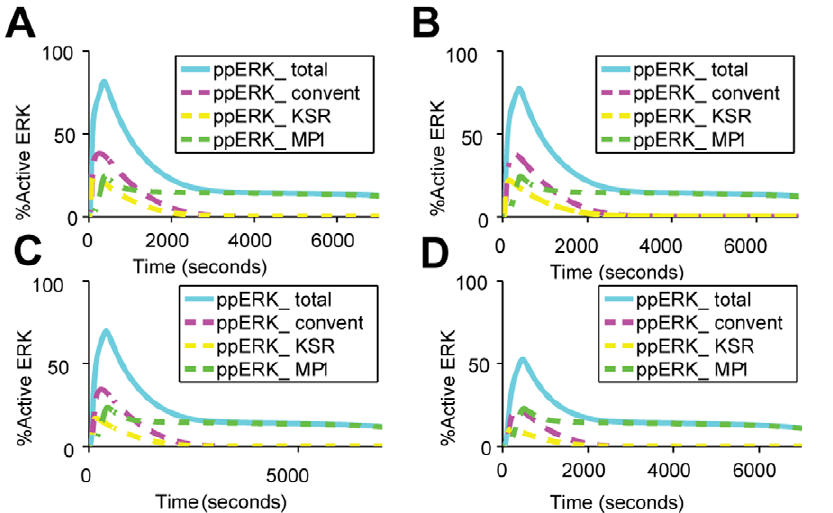
Figure 9. ERK activation regulated by membrane- and endosome-based modules. The contribution of the two membrane and one endosome components, the conventional EGFR–Ras–Raf–MEK–ERK signaling module (Convent), the KSR-mediated module (KSR), and the MP1 module (MP1), on ERK activation at various EGF concentrations: (A) 100 ng/ml, (B) 60 ng/ml, (C) 40 ng/ml, (D) 25 ng/ml.